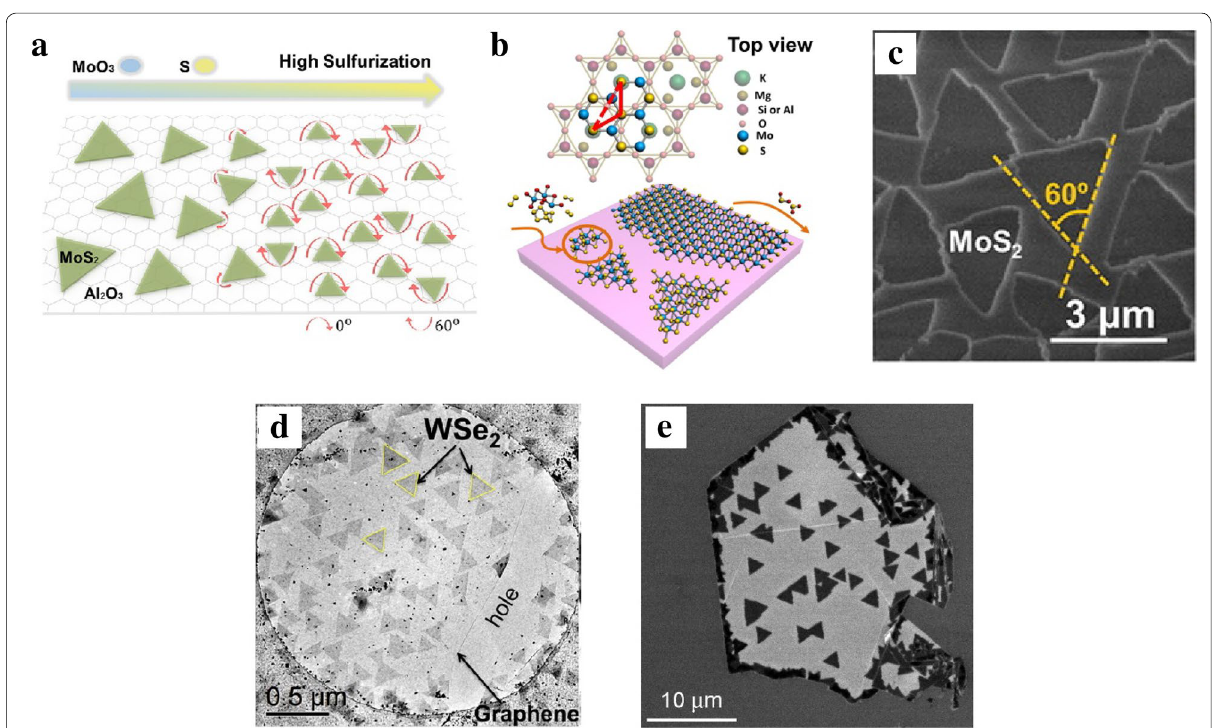
Fig. 4 Orientation control of TMDs materials. a Rotation of MoS 2 seeds as a function of precursor ratio (S/MoO 3 ) during initial nucleation steps [75]. Copyright 2017, American Chemical Society. b Epitaxial growth of MoS 2 on mica surface. c SEM image of MoS 2 on mica [76]. Copyright